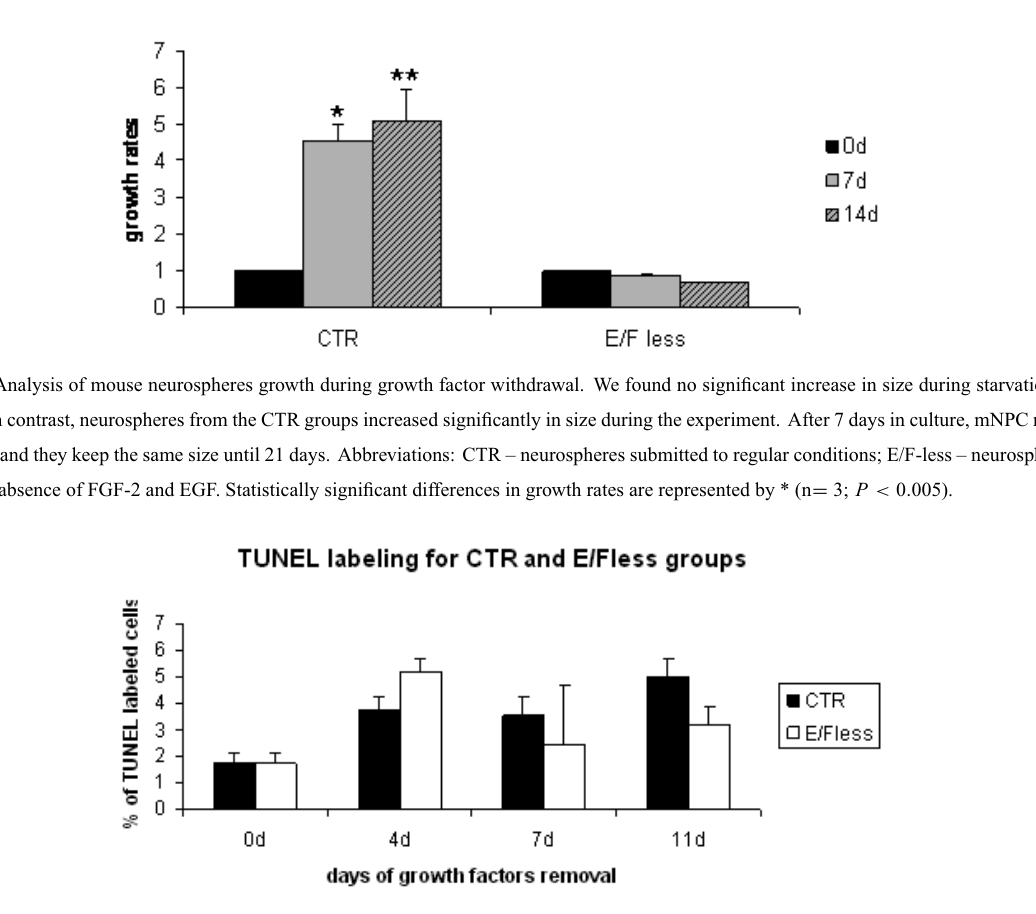
Fig. 3 – Apoptosis analysis of mNPC by TUNEL labeling. There were no significant changes in the percentage of TUNEL positive cells between the CTR and the E/F-less groups after 11 days of growth factor withdrawal (n = 3; P < 0 .